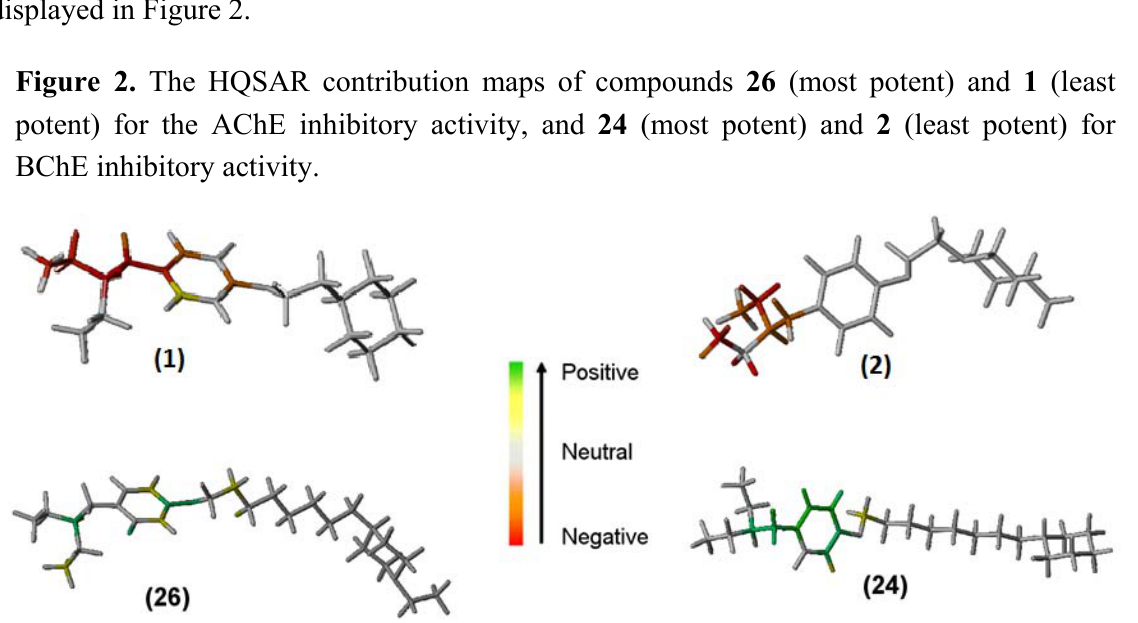
values of the training and test sets of 50